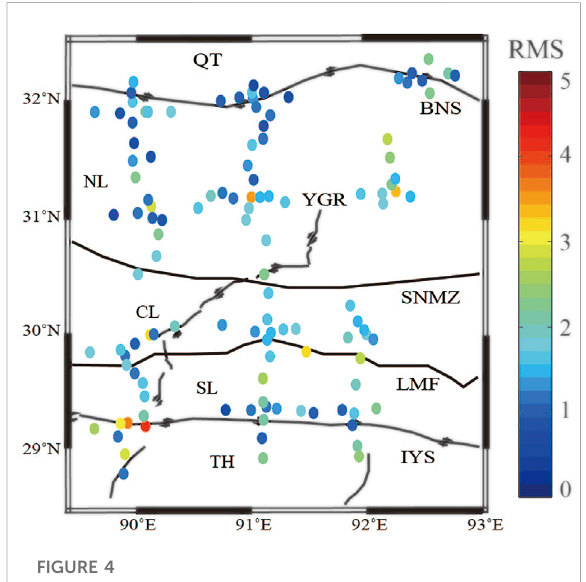
FIGURE 4 Site-by-siteRMSofthe3Dinversion.Themis fi tis < 3atalmost all